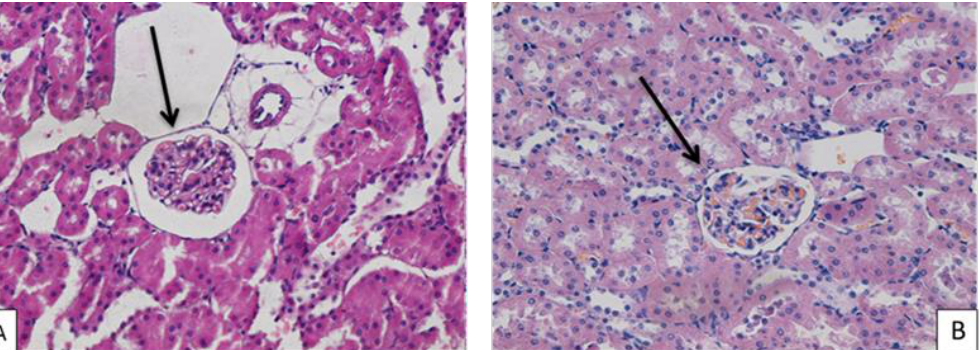
Figure 4. Microphoto of liver tissue of white rats of experimental ( A ) and control ( B ) groups. okr. Hematoxylin – eosin. Mag. ×400.